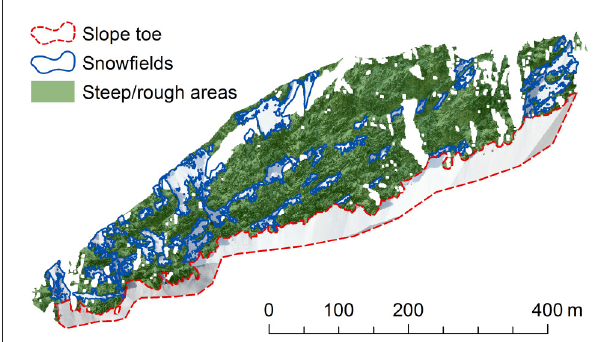
FIGURE 2 | Division of the rock face into three subareas: “slope toe,” “snowfields” and “steep/rough” areas. The orientation of the rock face is similar to the view in Figure 1B